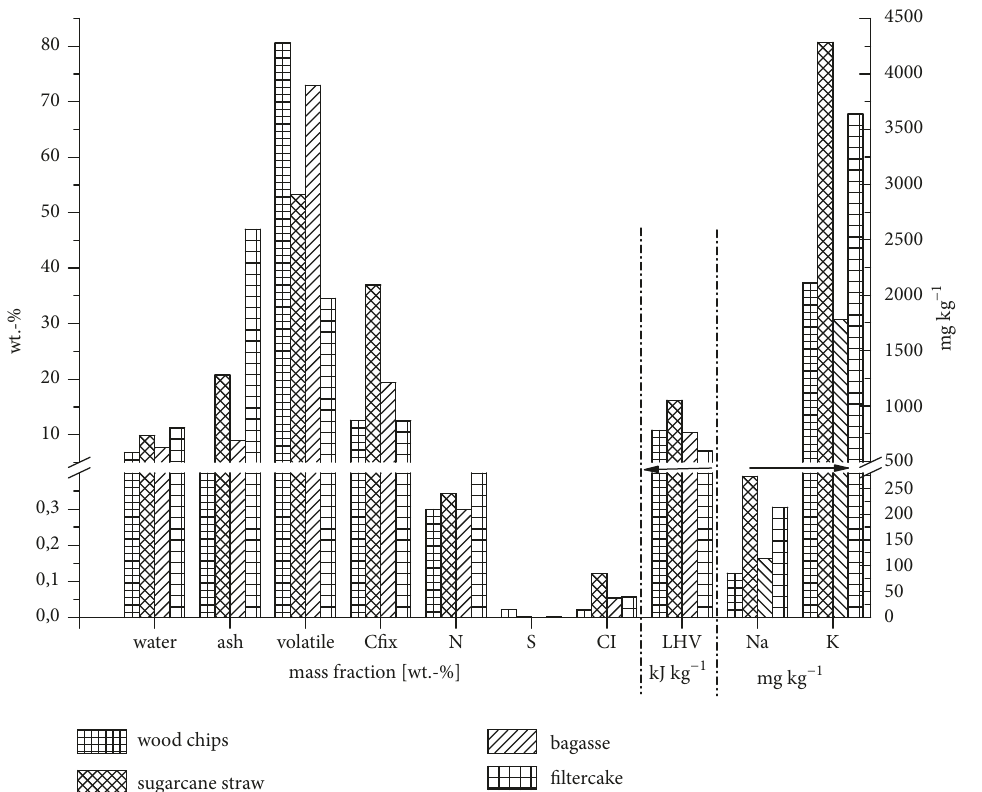
Figure 5: Comparison of selected fuel parameters.